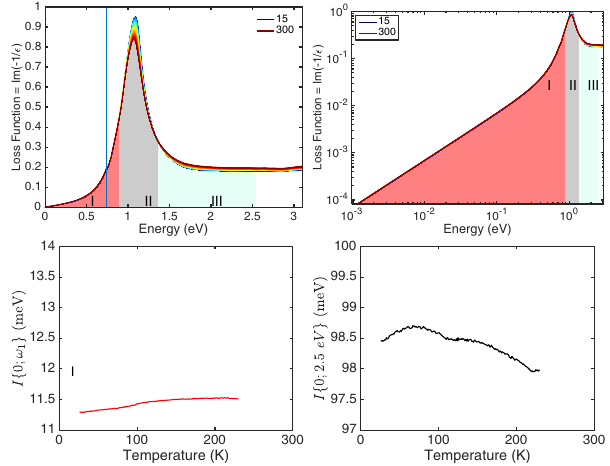
FIG. 21. Bi2223 optimally doped with the low-energy region